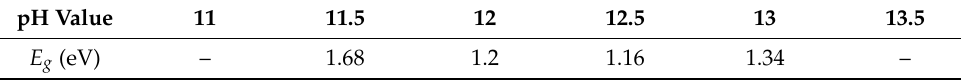
Figure 7. Plot of Abs 2 vs. h ν for obtaining the E g values of the MWCBD-CuO films obtained at different pH values. Table 2. Bandgap energy ( E g ) values of the MWCBD-CuO films deposited at different pH values.